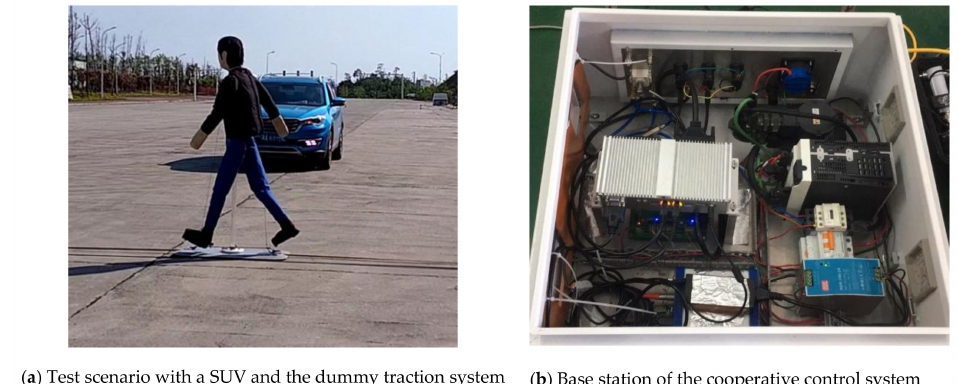
Figure 15. Test cooperative control performance of the PAEB test equipment in field